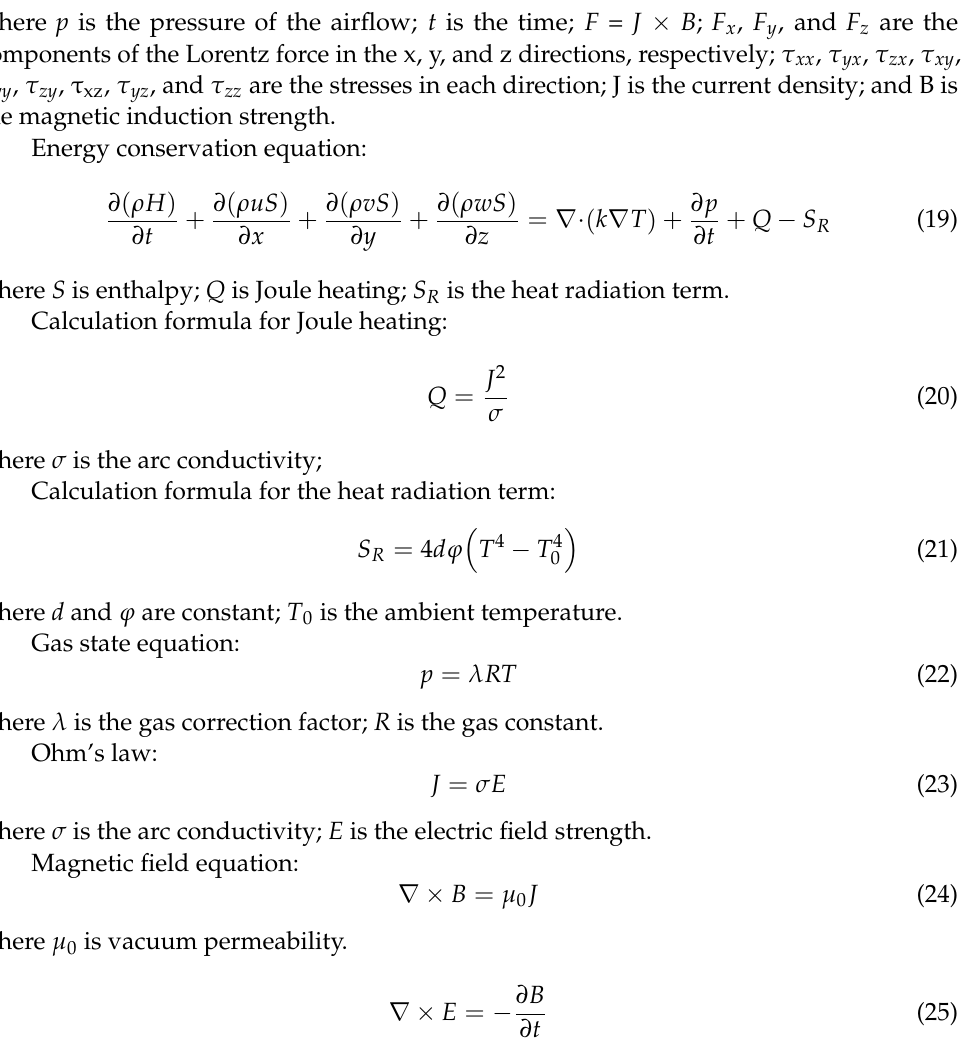
Figure 5. Distribution of Gaussian point positions in the arcing cylinder. 3.2. Simulation and Analysis Results When the gap between the device and high-voltage electrode breaks down, the im- pulse arc induces the action of an arc-quenching gas pill, which generates a high-energy compression wave acting on the arc. The arc is lengthened, which accelerates the process of dissociation, and ultimately, the arc is extinguished. The pressure variation curves for each observation point in the arc chamber are shown in Figure 6. Figure 6a shows the pressure variation curve at each monitoring point, taking into consideration the influence of the arc; Figure 6b shows the pressure variation curve at each monitoring point, without taking into consideration the influence of the arc.